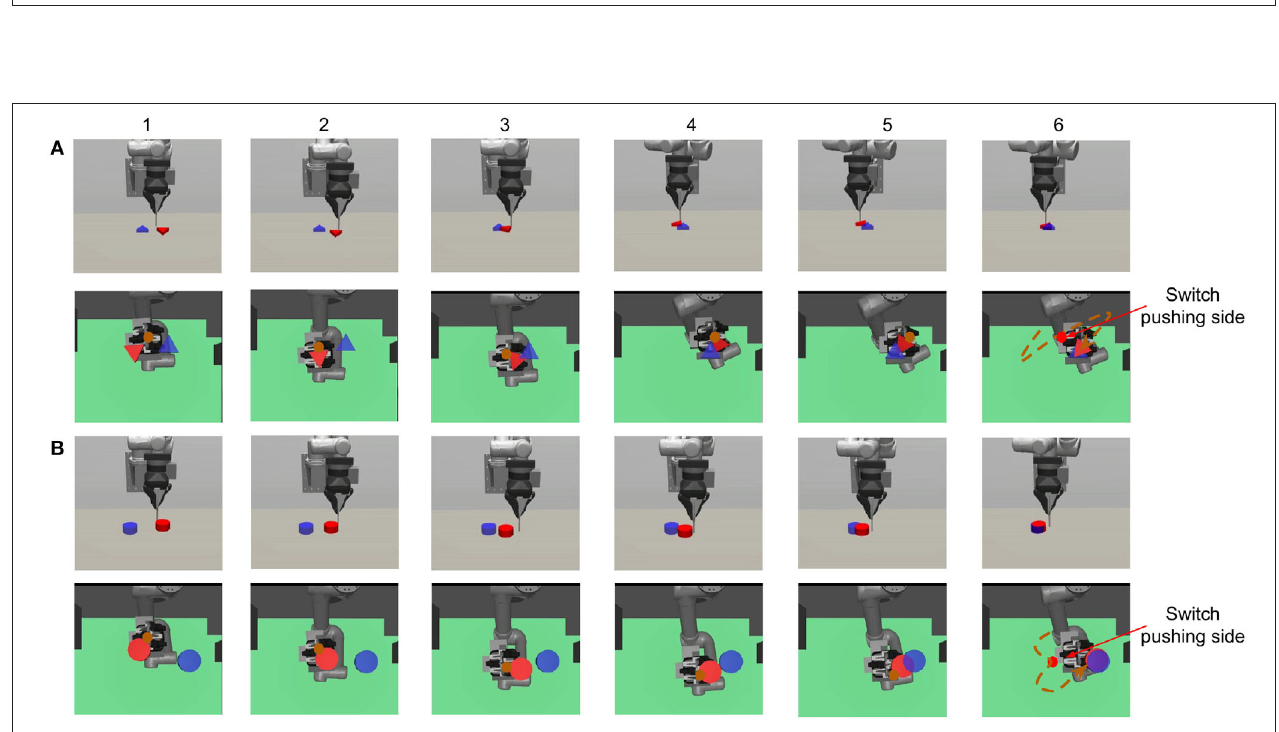
FIGURE 1 | Our experiment platform consists of a UR5 robot with a Robotiq 3-finger gripper that grasps the 3D-printed vertical pusher rod. Its cylindrical part, designed to touch and push the moving object, is 6mm in diameter. The pushing target placed on the transparent table is painted red to obtain masks easily through color filtering. The bottom camera (to get the input image) is set right below the table, and another front camera is added to record experimental videos.